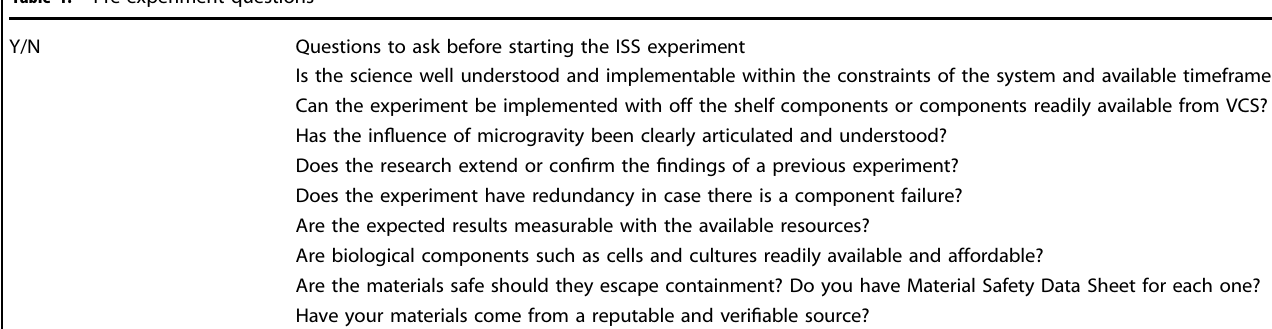
Table 1. Pre-experiment questions Y/N Questions to ask before starting the ISS